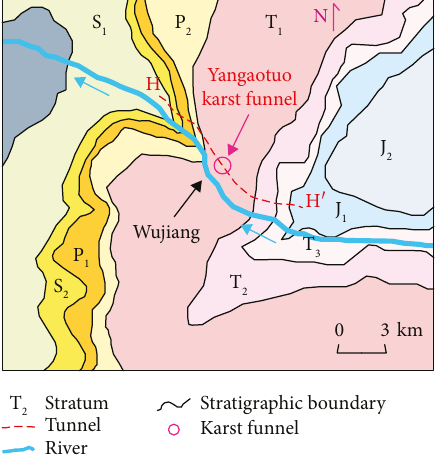
Figure 3: Geological map of the Wulong tunnel area.